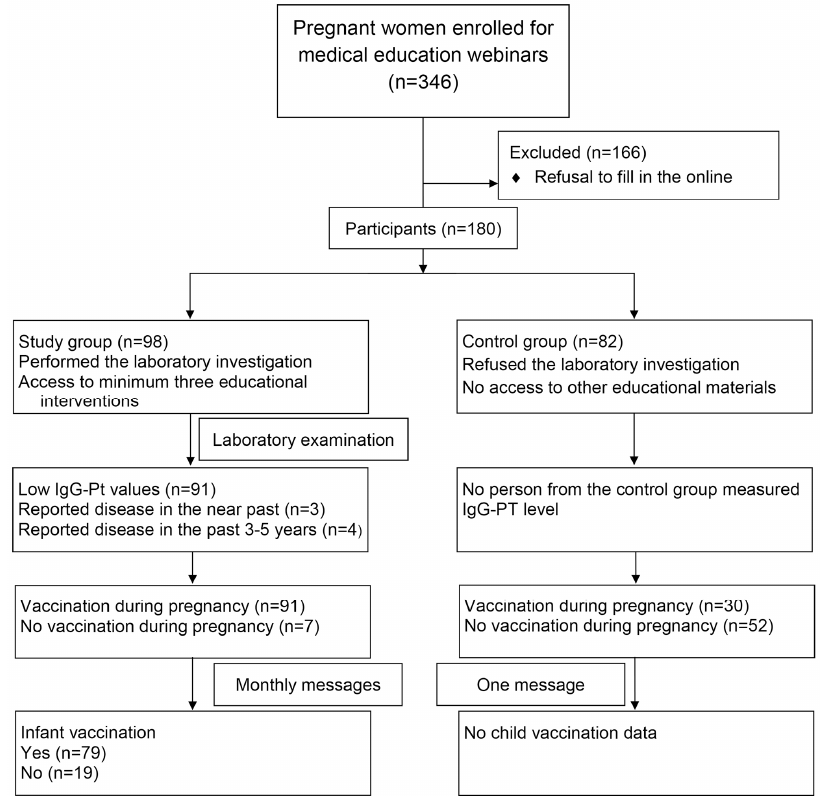
Figure 1. Study design (flow sheet).